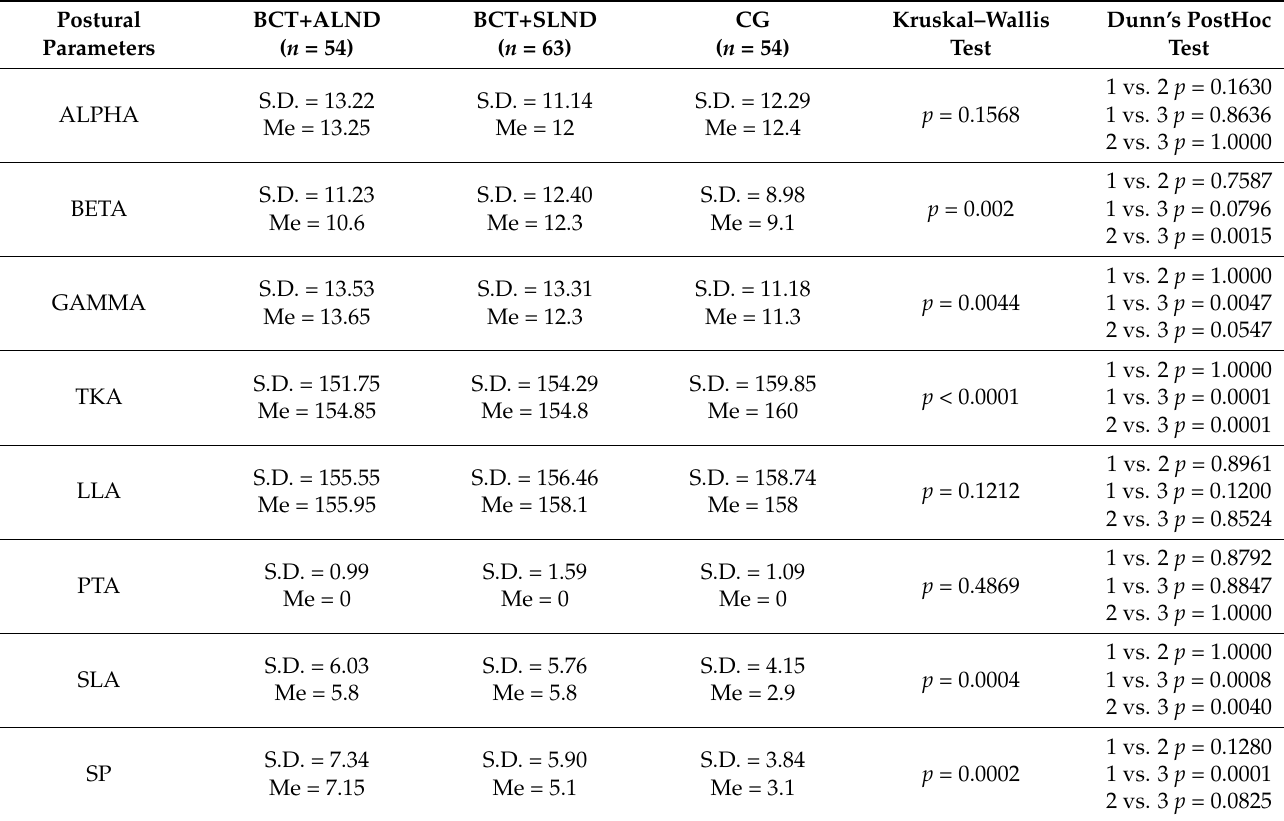
Table 2. Analysis of ALPHA, BETA, GAMMA, TKA, LLA, PTA (mm), SLA (mm) and SP (mm) in studied groups (BCT+ALND, BCT+SLNB,